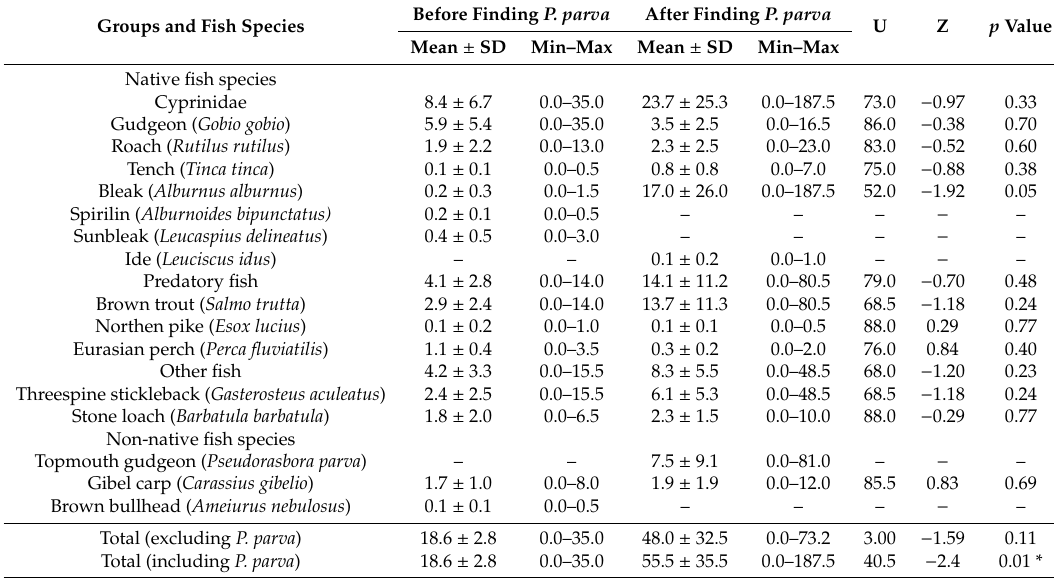
Total (excluding P. parva )